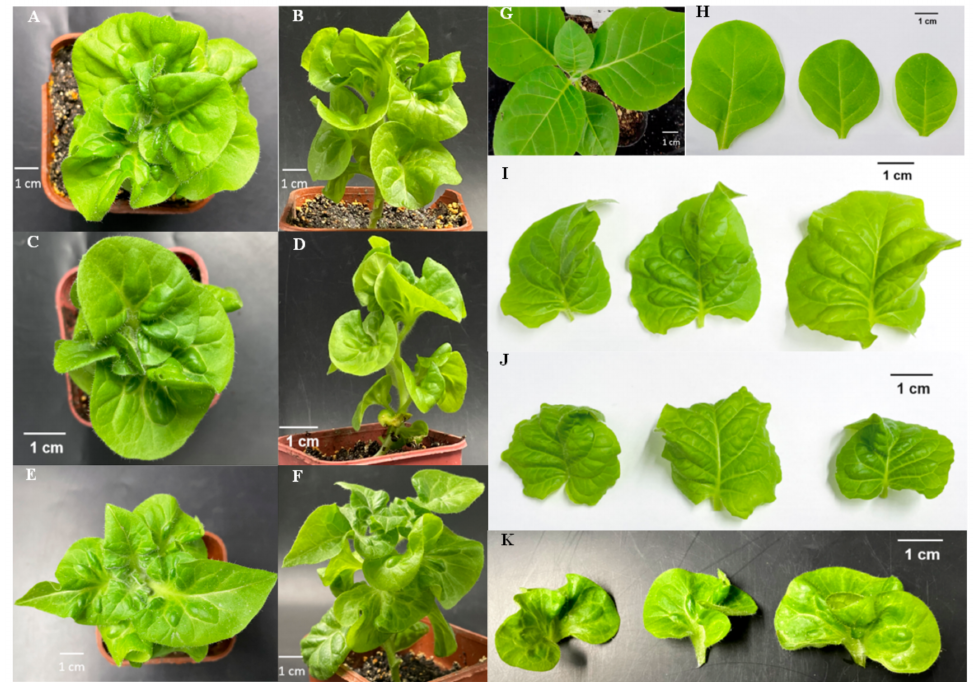
Figure 8. Phenotype observation of tobacco plant overexpressing chrysanthemum KNOX gene (( A , B , I ) show the top view, front view, and leaves of tobacco plants overexpressing chrysanthemum CmKNAT6 gene, respectively; ( C , D , J ) show the top view, front view, and leaves of tobacco plants overexpressing chrysanthemum CmKNAT1 gene, respectively; ( E , F , K ) show the top view, front view, and leaves of tobacco plants overexpressing chrysanthemum CmSTM gene, respectively; ( G , H ) show wild tobacco plants and their leaves).